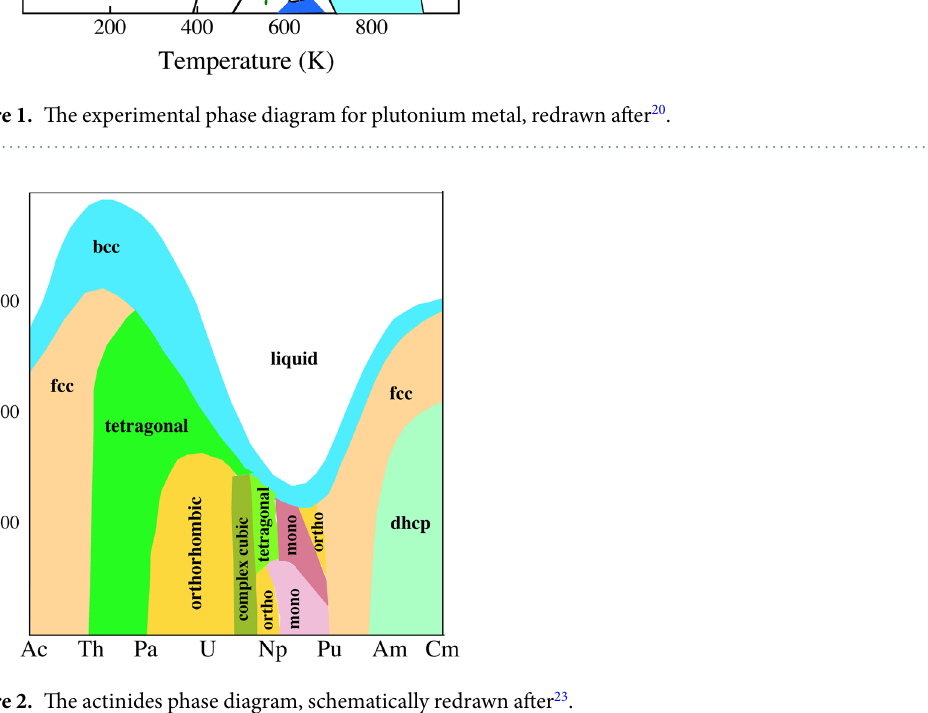
Figure 2. The actinides phase diagram, schematically redrawn after 23